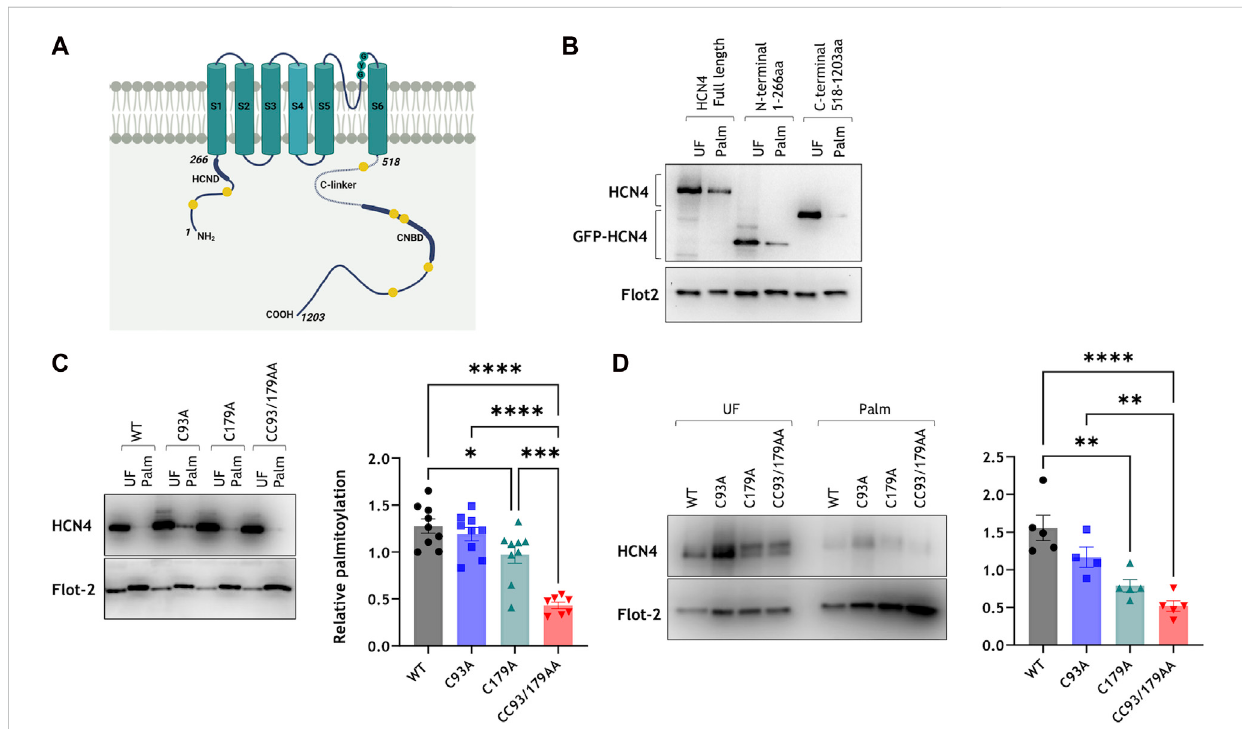
Palmitoylation site mapping in HCN4. (A) HCN4 schematic indicating the positions of the HCN domain (HCND) in the intracellular amino terminus, theC-linkerandcyclicnucleotidebindingdomain(CNBD)intheintracellularcarboxylterminus,andallintracellularcysteines(yellowcircles)intheamino (C93, C179) and carboxyl (C586, C662, C679, C755, C887) termini. (B) Palmitoylation of full length HCN4, YFP-N-terminus (1-266) and YFP-C-terminus (518-1203)intransientlytransfectedHEK-293cellswasassessedbyacyl-RAC.FulllengthHCN4wasdetectedwithanti-HCN4antibodyandtheYFP fused N-/C- terminal fragments were detected with anti-GFP antibody. Flotillin-2 enrichment (Flot 2) con fi rms the ef fi ciency of the acyl-RAC assay. UF, Unfractionated cell lysate; Palm: Palmitoylated proteins; representative fi gure of n = 8. (C) Site-directed mutagenesis on the YFP-fused N-terminus revealscysteine93and 179as palmitoylationsites. (D) Palmitoylation ofstablyexpressedwildtypeandmutantHCN4con fi rmcysteine 179as theprimary palmitoylation site of HCN4. * p < 0.05, ** p < 0.01, *** p < 0.001 and **** p < 0.0001, one way ANOVA followed by Tukey ’ s post hoc test. All groups are not signi fi cantly different from each other except where